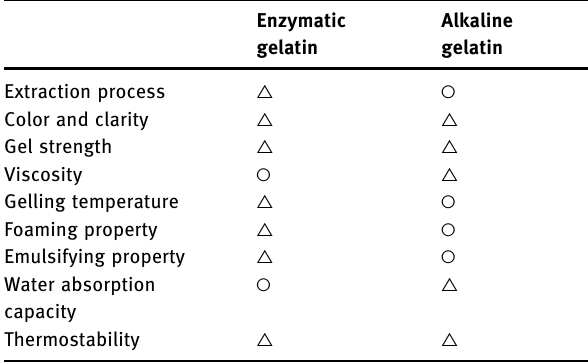
Figure 7: Water absorption capacity of the gelatin samples.